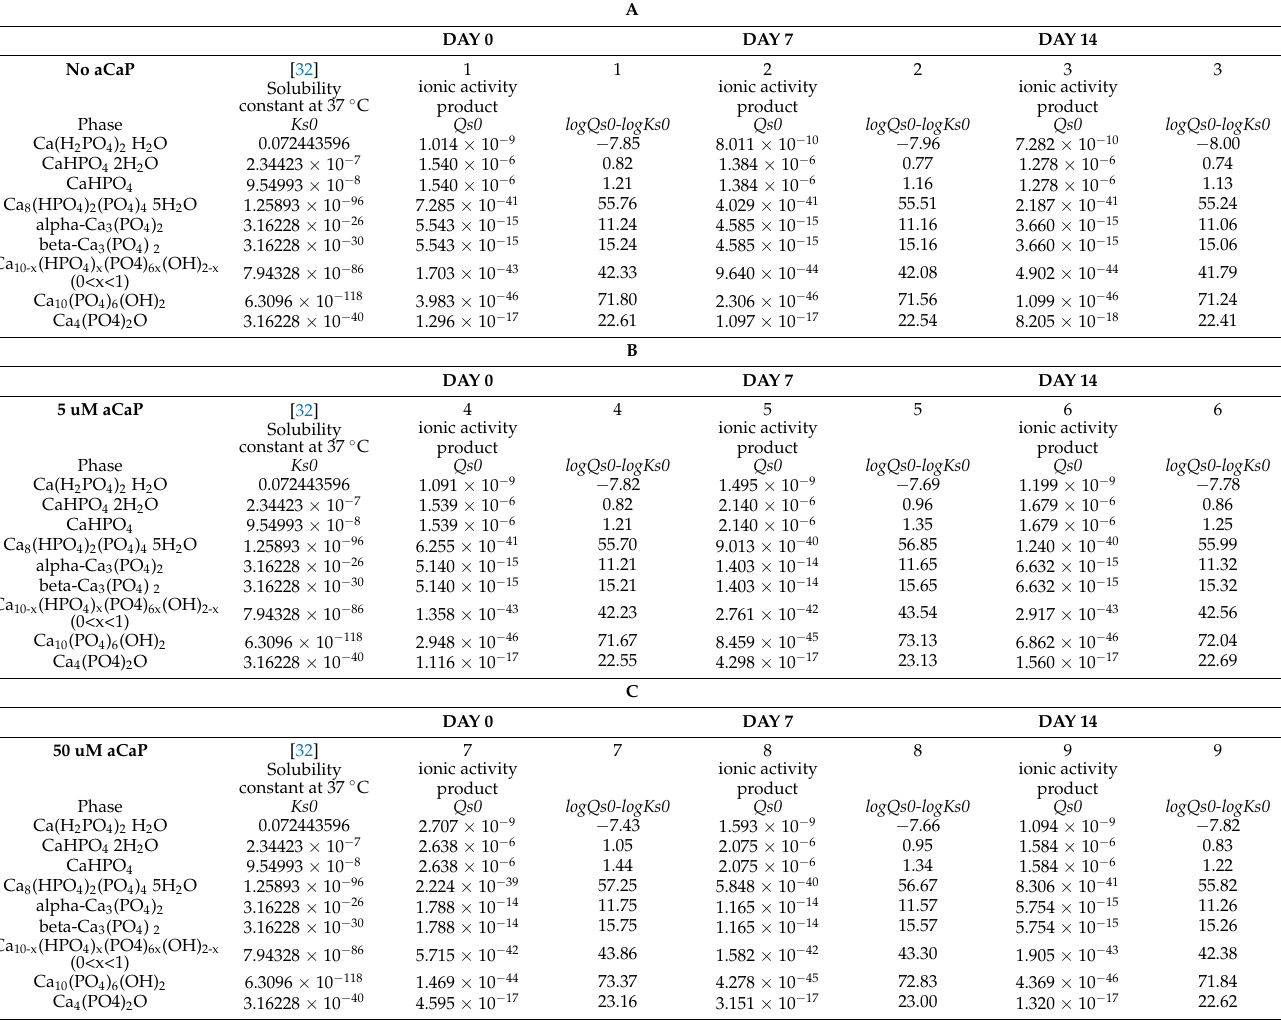
Table 4. Ionic activity products ( Qs0 ) and differences between logQs0-logKs0 for nine different conditions (numbered 1–9), i.e., no aCaP, 5, or 50 µ g/mL aCaP and time points 0, 7, and 14 days, respectively, calculated based on measured free calcium and phosphate ion concentrations (see Figure 2). No corrections regarding ionic strength were